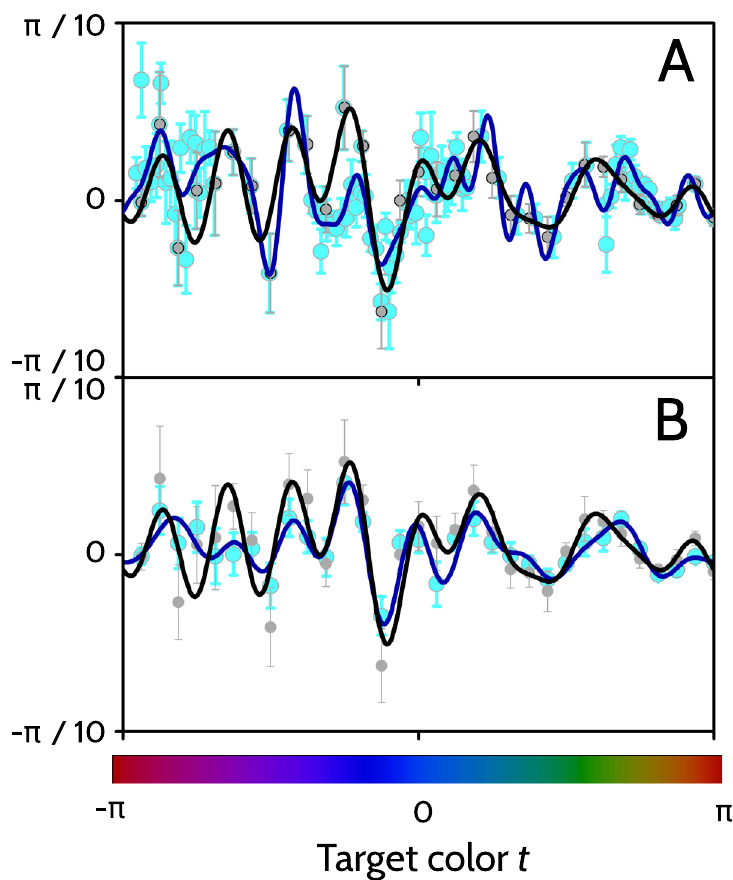
Fig 11. Fitted errors Δ ( t ) in two control experiments. A: Fitted error obtained for an observer that played the normal 32-color game (gray data points, black fitted curve), and a modified 96-color game (cyan data points, blue fitted curve). Both games were played 10 times. B: Fitted error obtained for an observer that played the normal 32-color game 10 times (gray data points, black fitted curve), and 26 times (cyan data points, blue fitted curve).